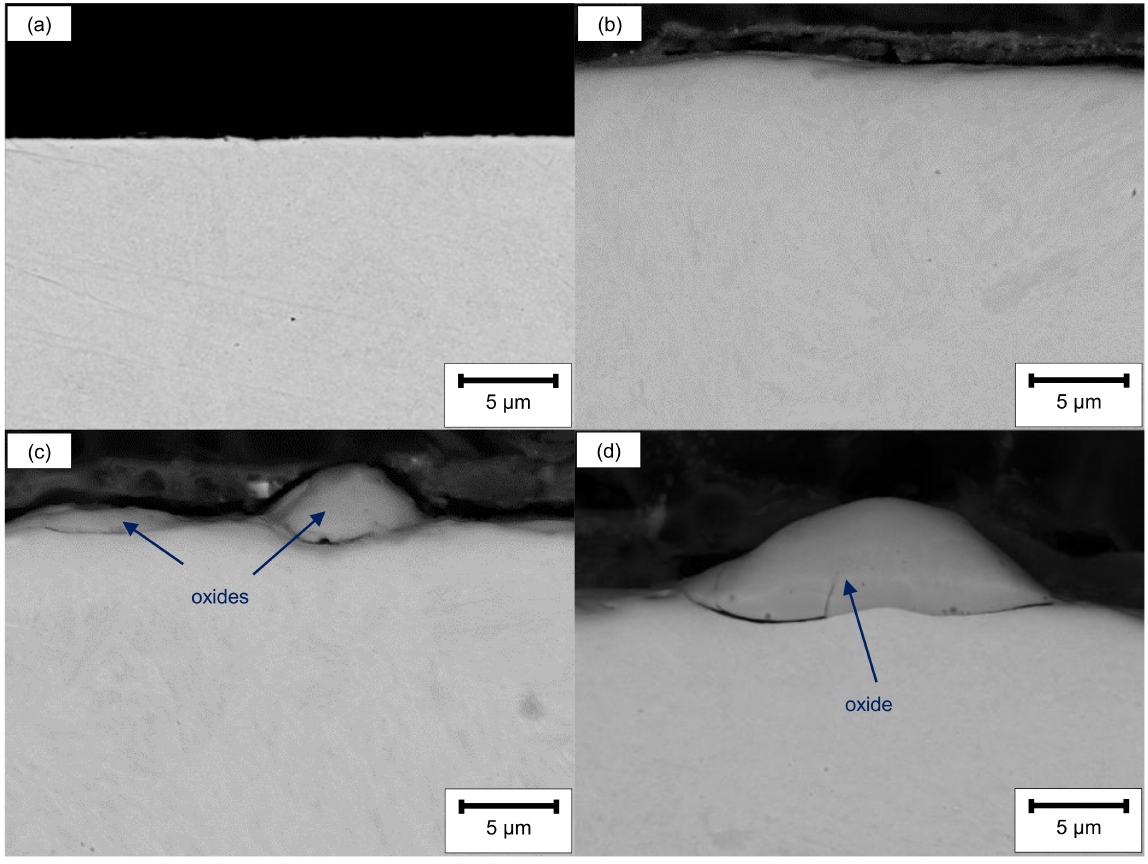
Figure 3. SEM cross-sections before oxidation of ( a ) ground, ( b ) LCM-H 3 PO 4 -6W, ( c ) LCM-NaNO 3 -6W and ( d ) LCM- NaNO 3 -18W 42CrMo4 steel.